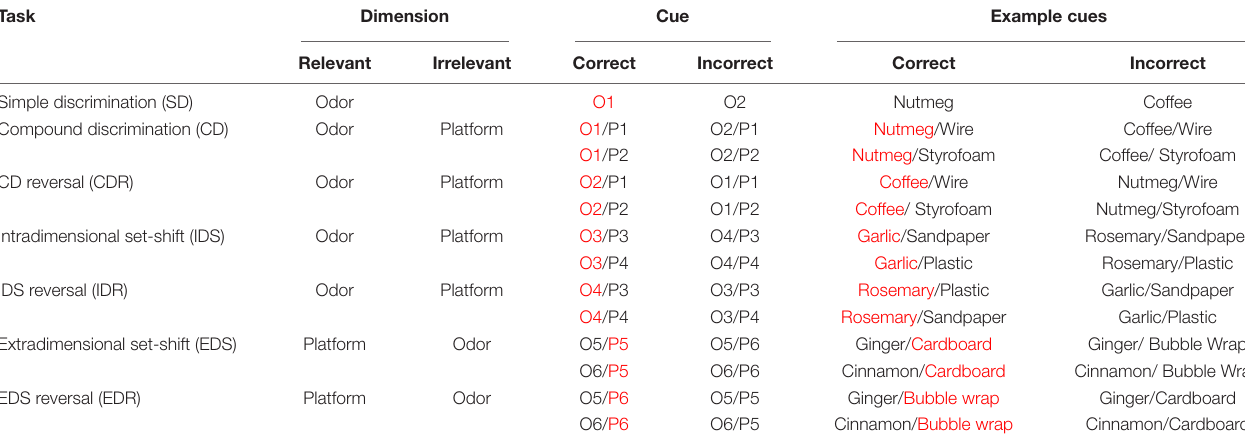
TABLE 1 | Examples of correct and incorrect odor and platform material cues used in each stage of the attentional set-shifting task (ASST). Task